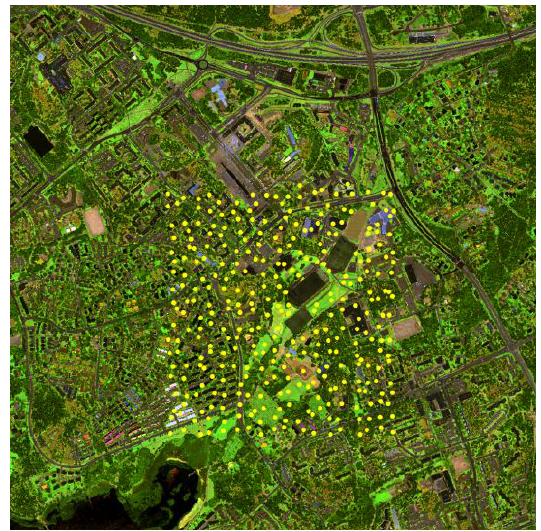
Figure 1. Three-channel intensity image of the 2 km × 2 km study area (Channels 1–3 in red, green and blue, respectively). Reference points used in the analysis are shown on the